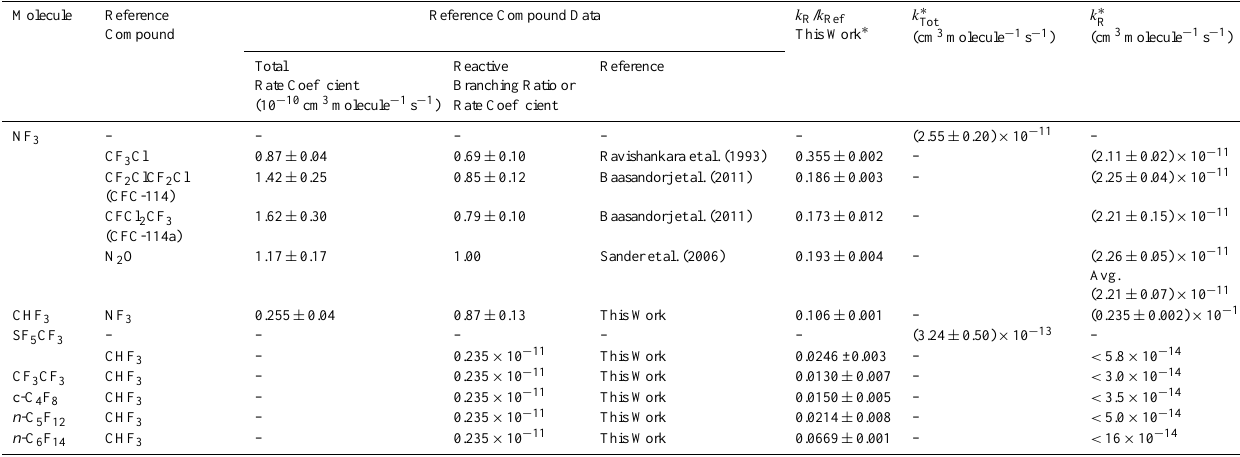
Table 2. Summary of the total, k Tot , and reactive, k R , O( 1 D) reaction rate coefficients measured in this work at 296K. Molecule